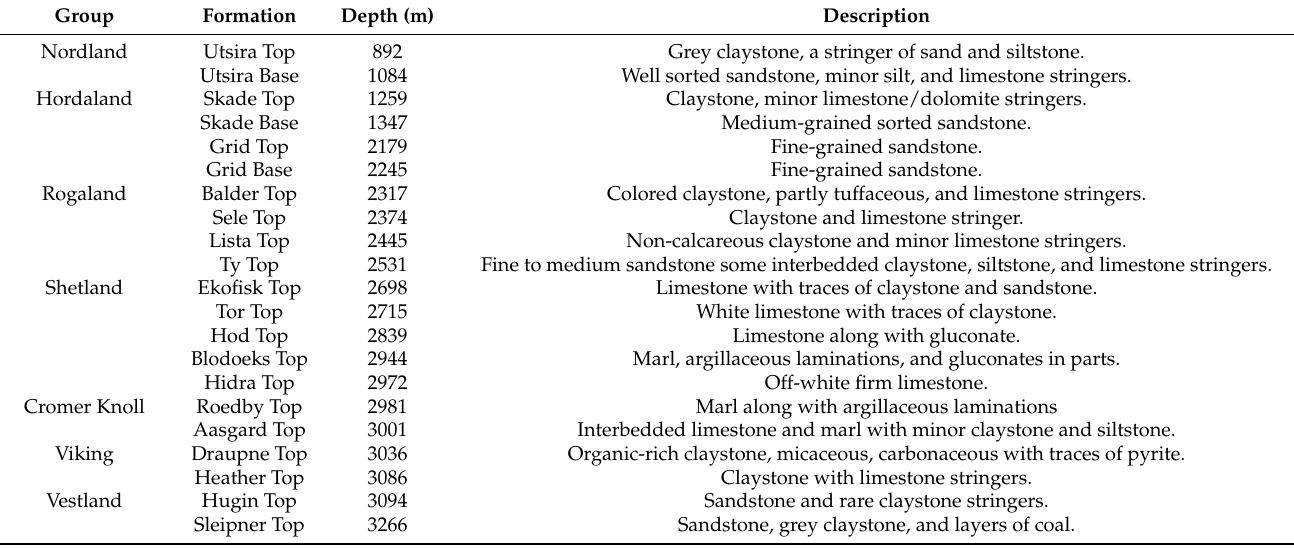
Figure 3. Geological location of Volve oil and gas field (courtesy: Equinor website) [43]. Table 1. Geological prognosis of Well 15/9-F-12 under study (courtesy: Equinor company) [43]. Group Formation